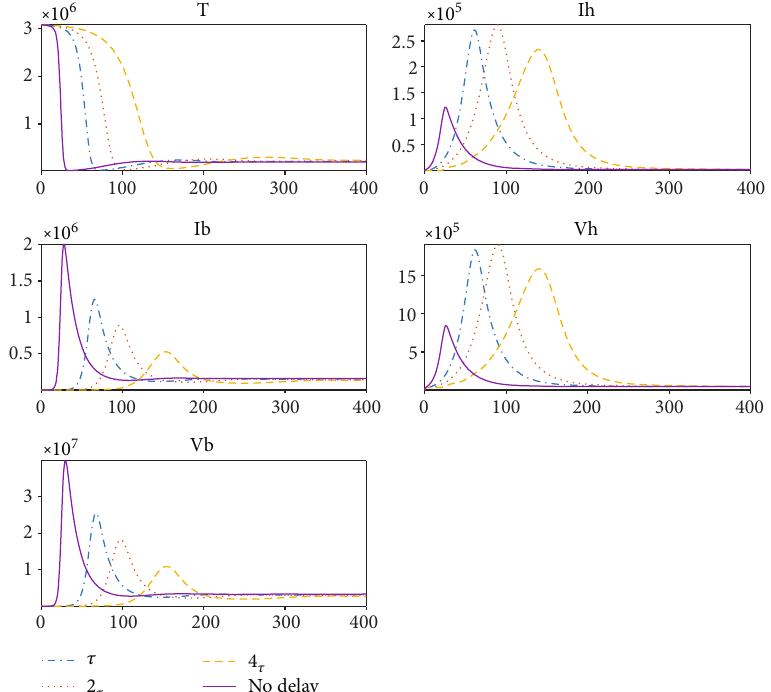
Figure 4: Dynamics of delayed system (1) with varying delay ( τ ) values. Parameter values are as shown in Table 1. Horizontal axes represent time in days.